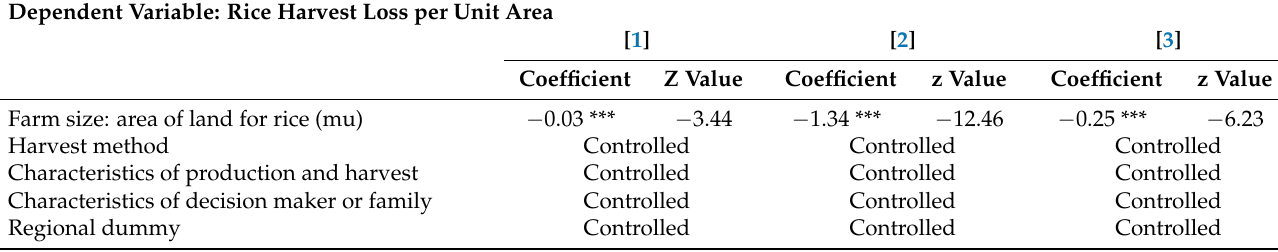
Table 8. Estimation results of the robustness